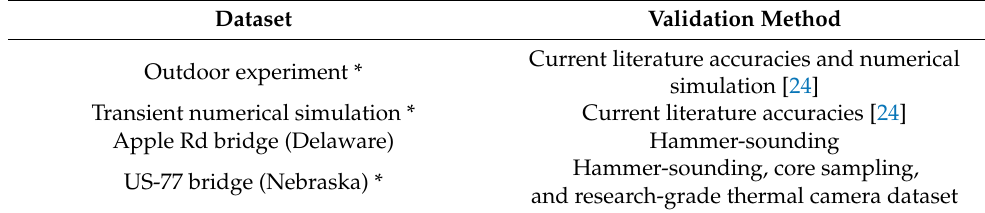
Table 2. Datasets and validation